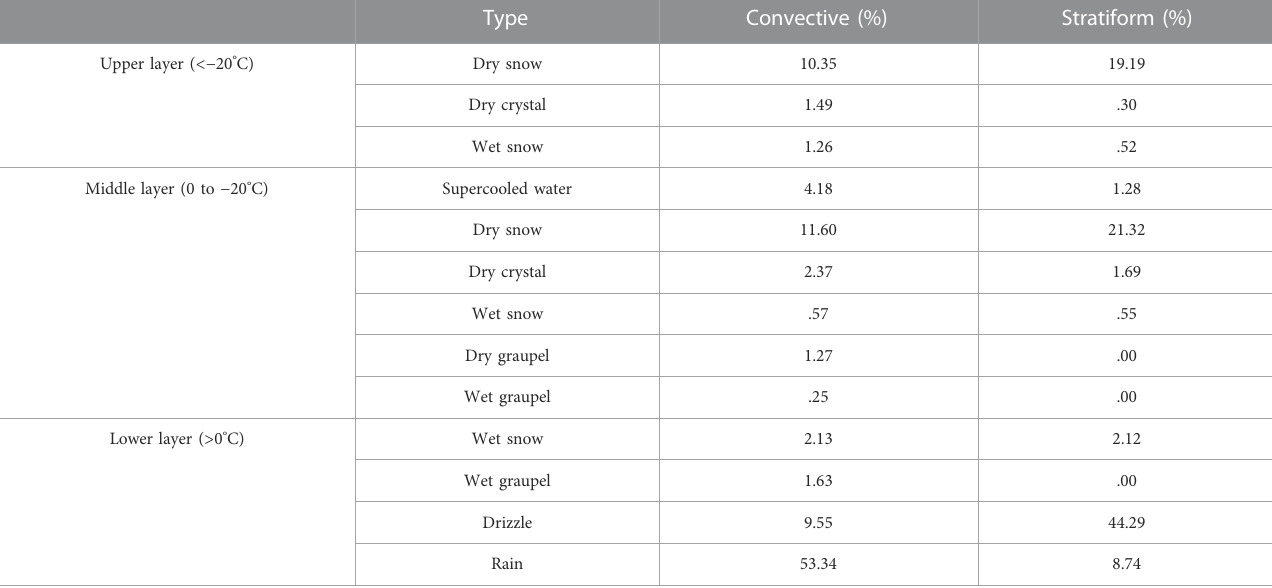
TABLE 4 The relative content of hydrometeors in different layers of the convective and stratiform